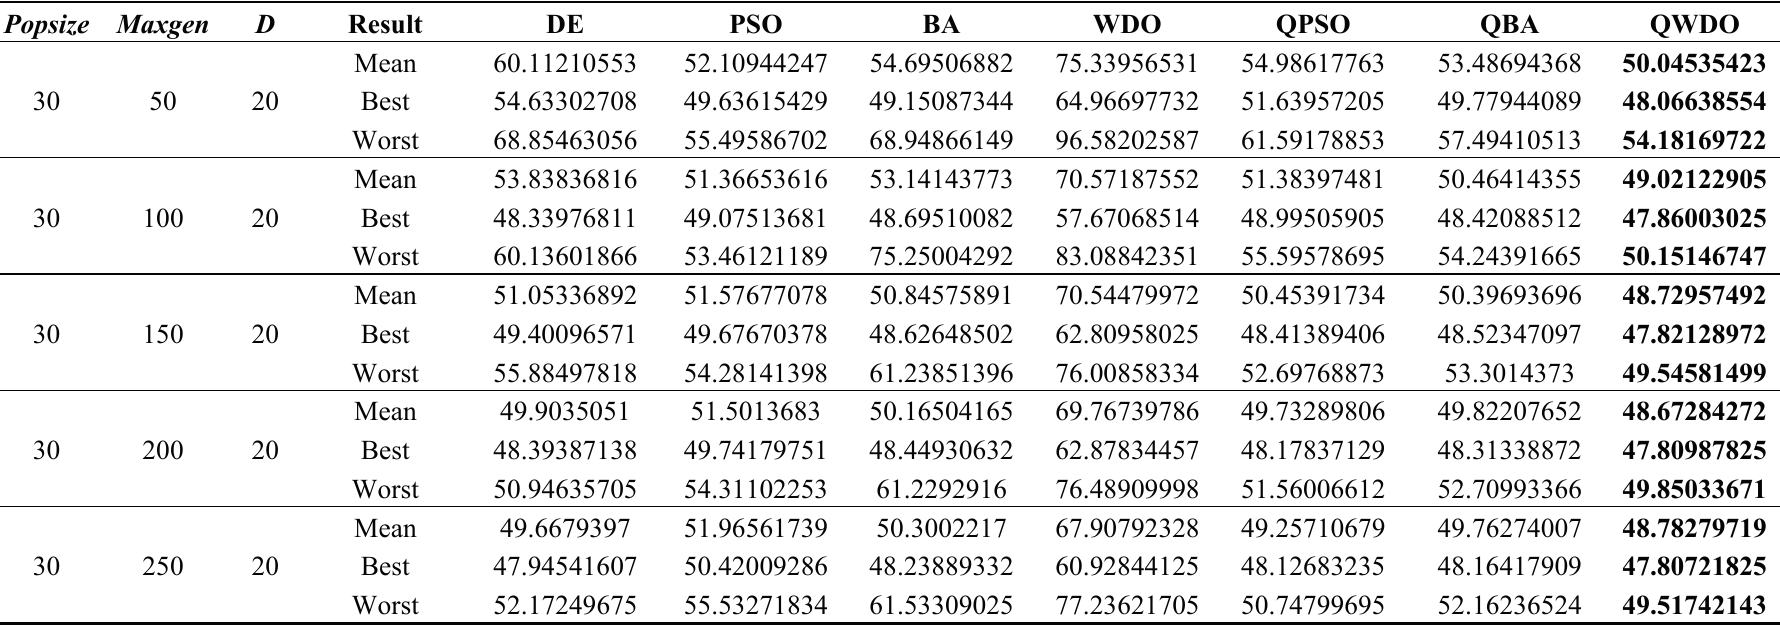
Table 13. Experimental results for the second test instance in different Maxgen